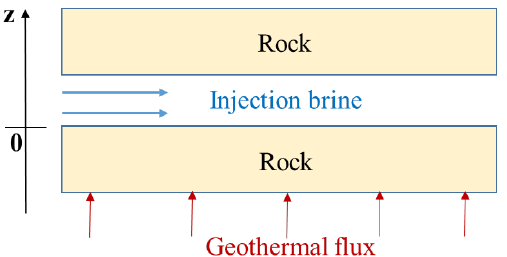
Figure 3. Illustration of the heat transfer system with geothermal heat flux from below. Fluid is injected from the left side of the system.